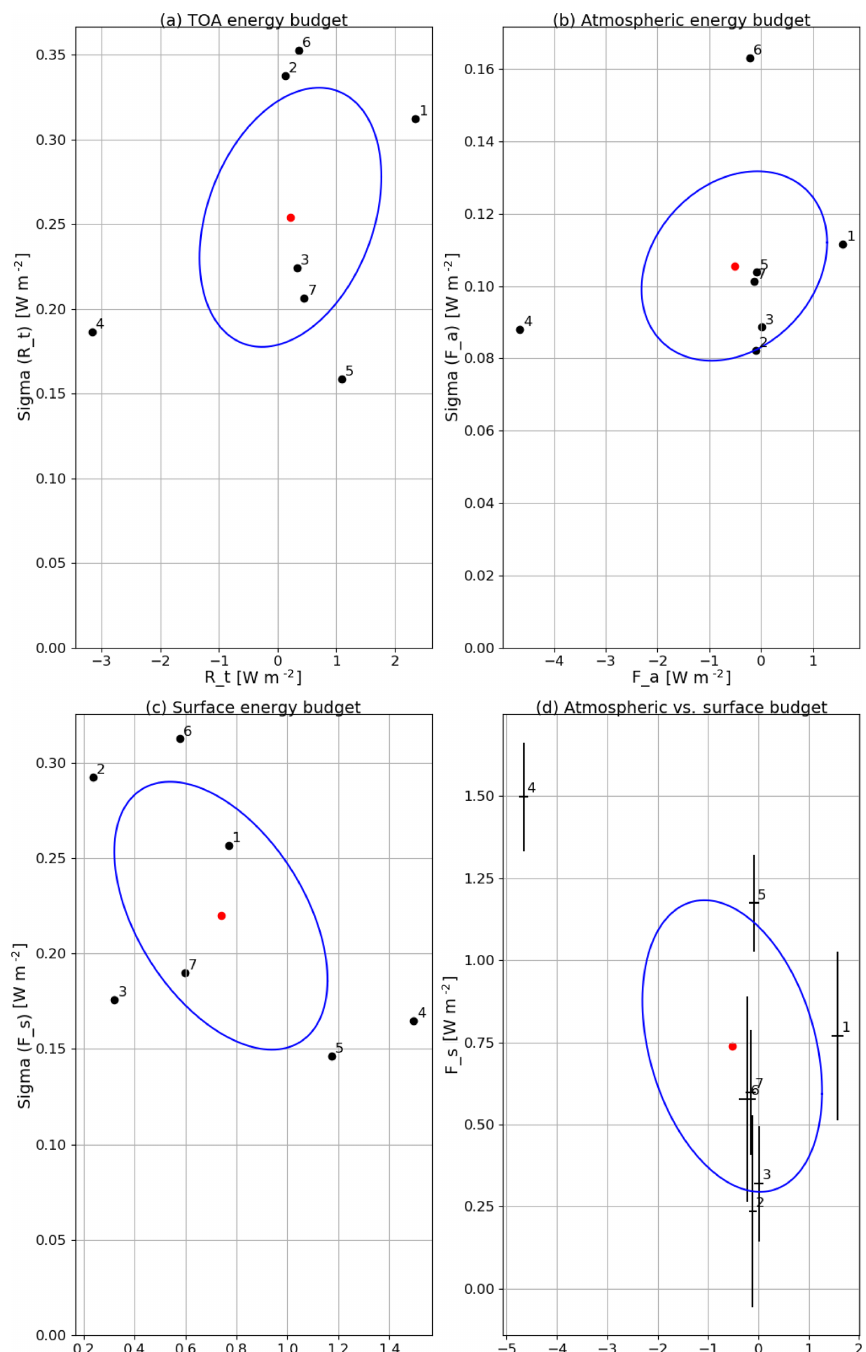
Figure 7. Multi-model ensemble scatter plots of annual mean averaged quantities vs. inter-annual variability in the piC scenario for (a) TOA energy budget, (b) atmospheric energy budget and (c) surface energy budget. Panel (d) shows the atmospheric energy budget vs. the surface energy budget, with whiskers denoting the inter-annual variability as in panels (b) and (c) . Blue ellipses denote the σ standard deviation of the multi-model mean (denoted by the red dot). Model IDs are (1) BNU, (2) Can2, (3) IPSL-M, (4) MIR5, (5) MIR-C, (6) MPI-LR and (7)